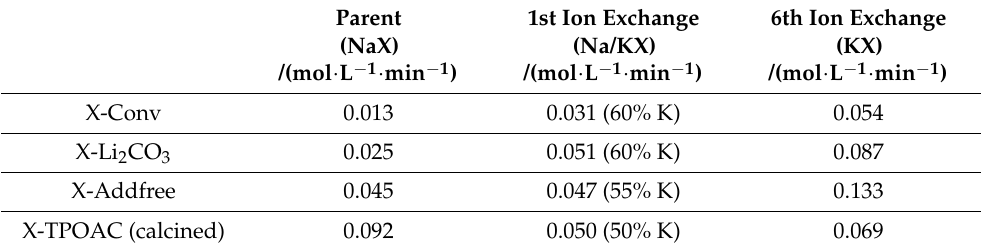
Table 3. Initial reaction rates for all four zeolite X samples at 100 ◦ C reaction temperature after the first and sixth potassium